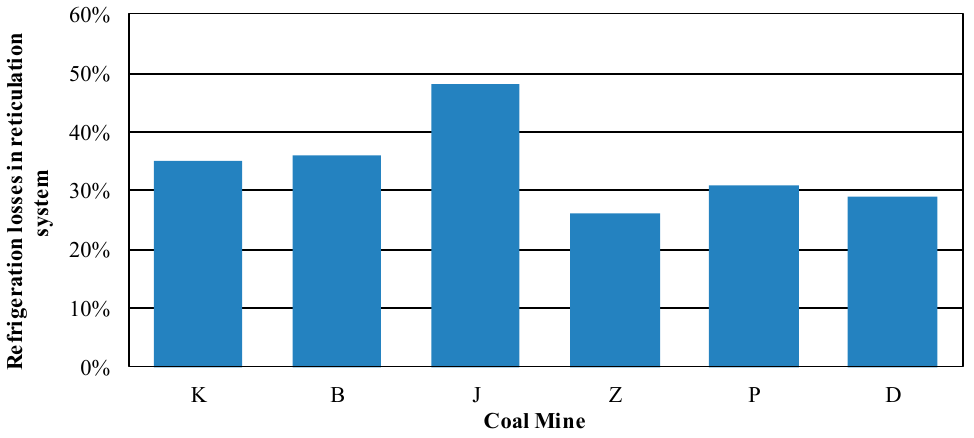
Figure 5. Thermal losses in the piping of the investigated cooling systems.